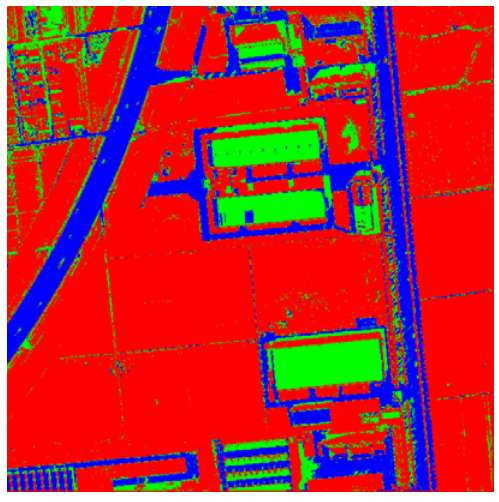
Figure3. Classification result of MSRF